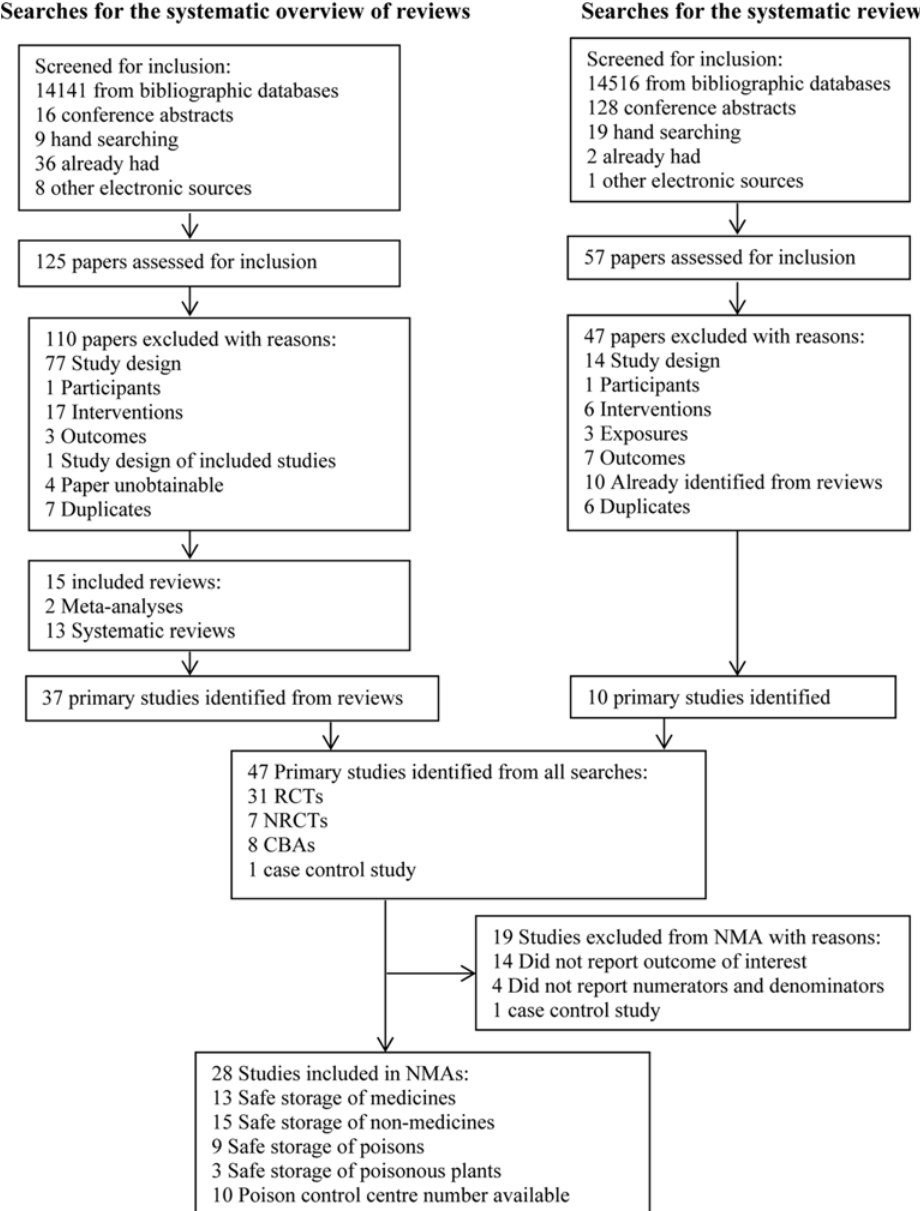
Fig 1. PRISMA flow chart for the systematic overview of reviews and systematic review of primary